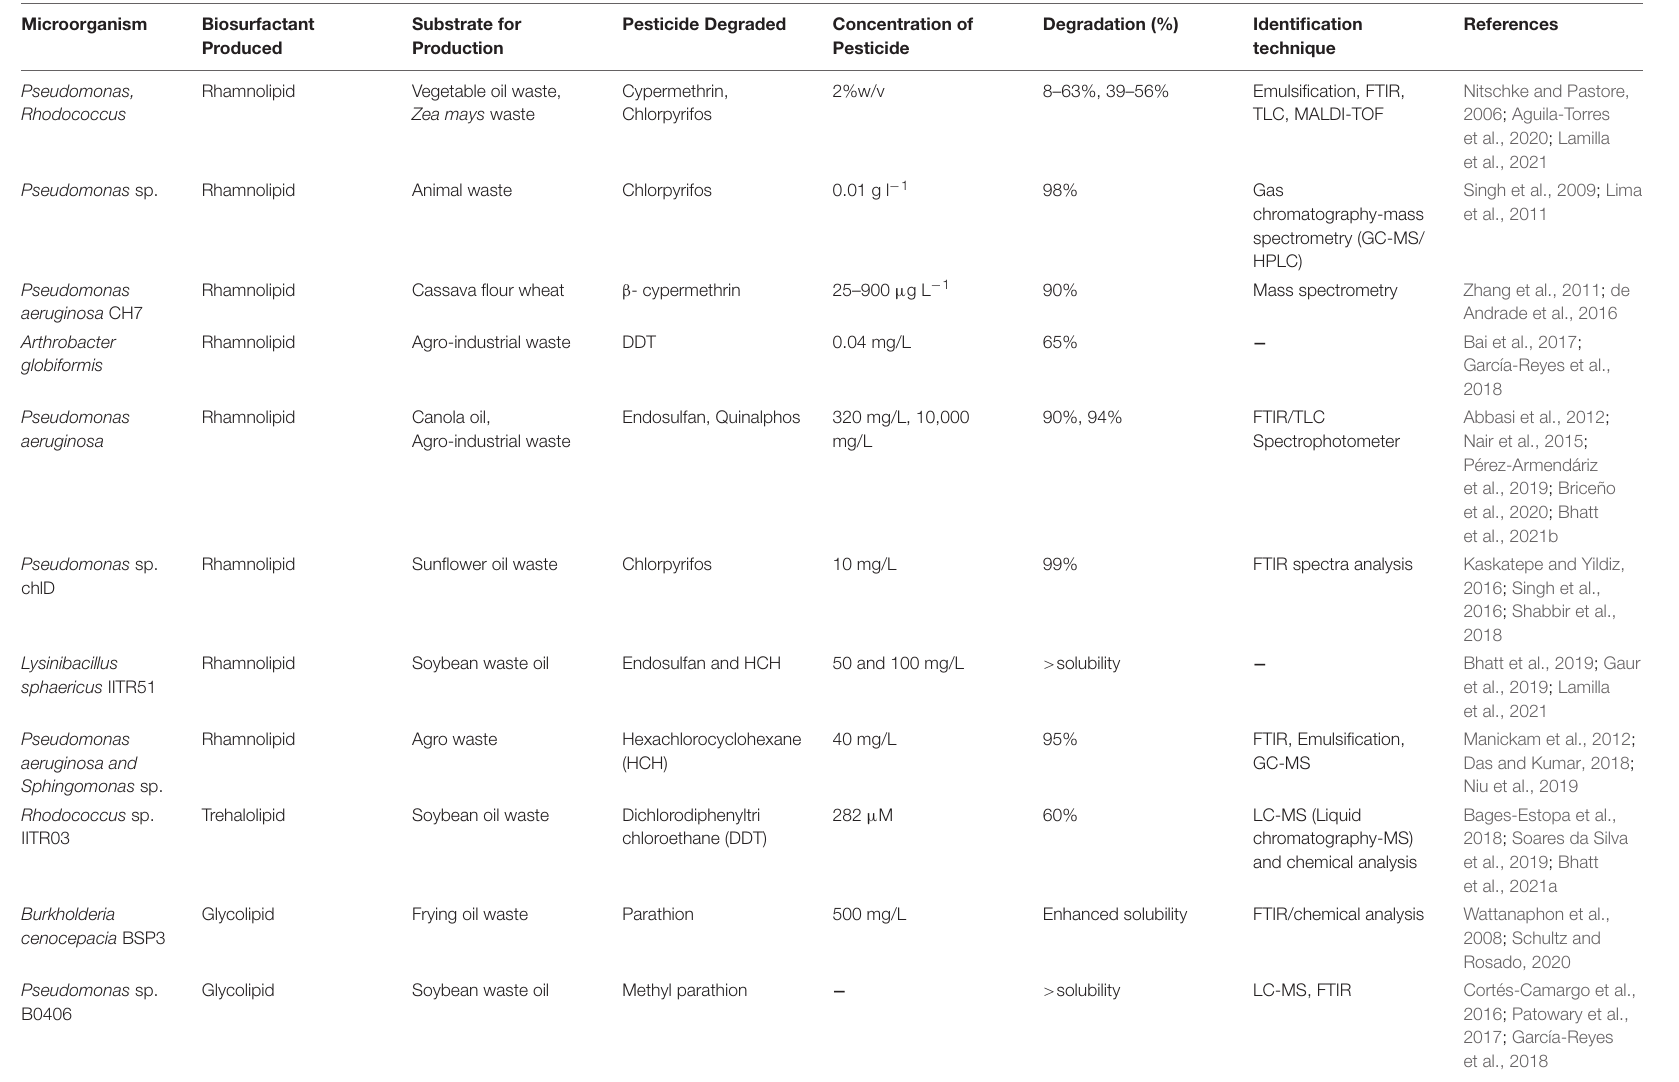
TABLE 1 | Microbial biosurfactants and their role in pesticides